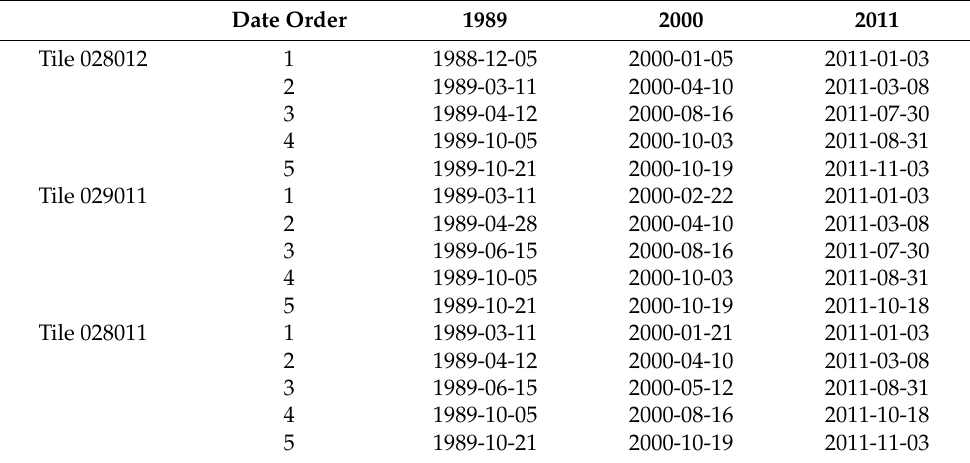
Figure 3. Examples of Landsat 5 imagery used for this study from all three time periods visualized in false color. Note that clouds over water and optically thin clouds over land were included. From left to right: April 1989 imagery, August 2000 imagery, and August 2011 imagery. Table 1. Dates for all Landsat images used organized by tile ID and year. Date format is YYYY-MM-DD. Tile 028011 is the northwest component of the study area, tile 029012 is the furthest east primarily encompassing the barrier islands of North Carolina, and tile 028012 is the southern section of the study area.